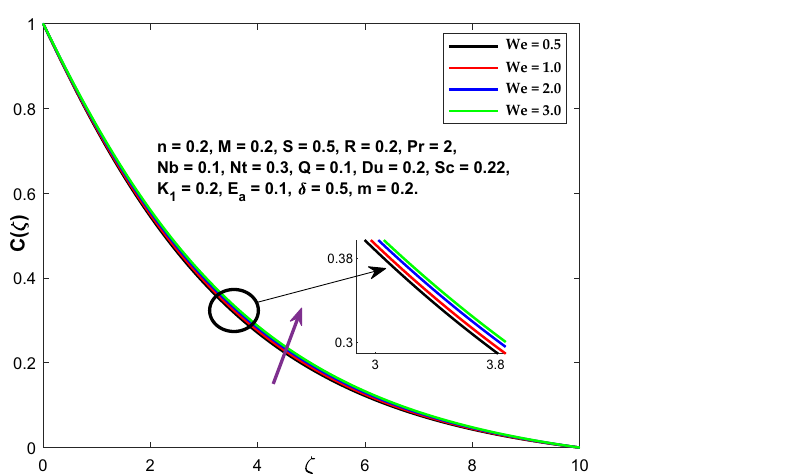
Figure 8. Character of We versus C (ζ) .